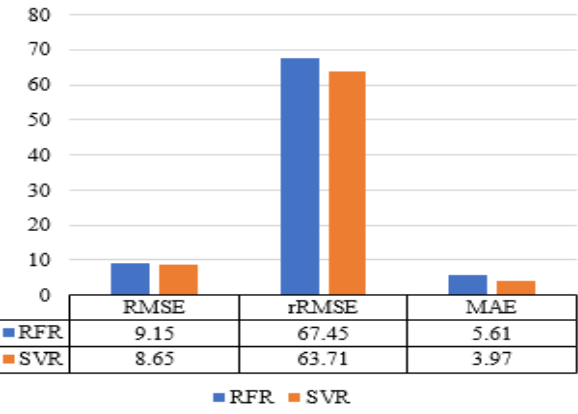
Figure 5. ML models performance on the second